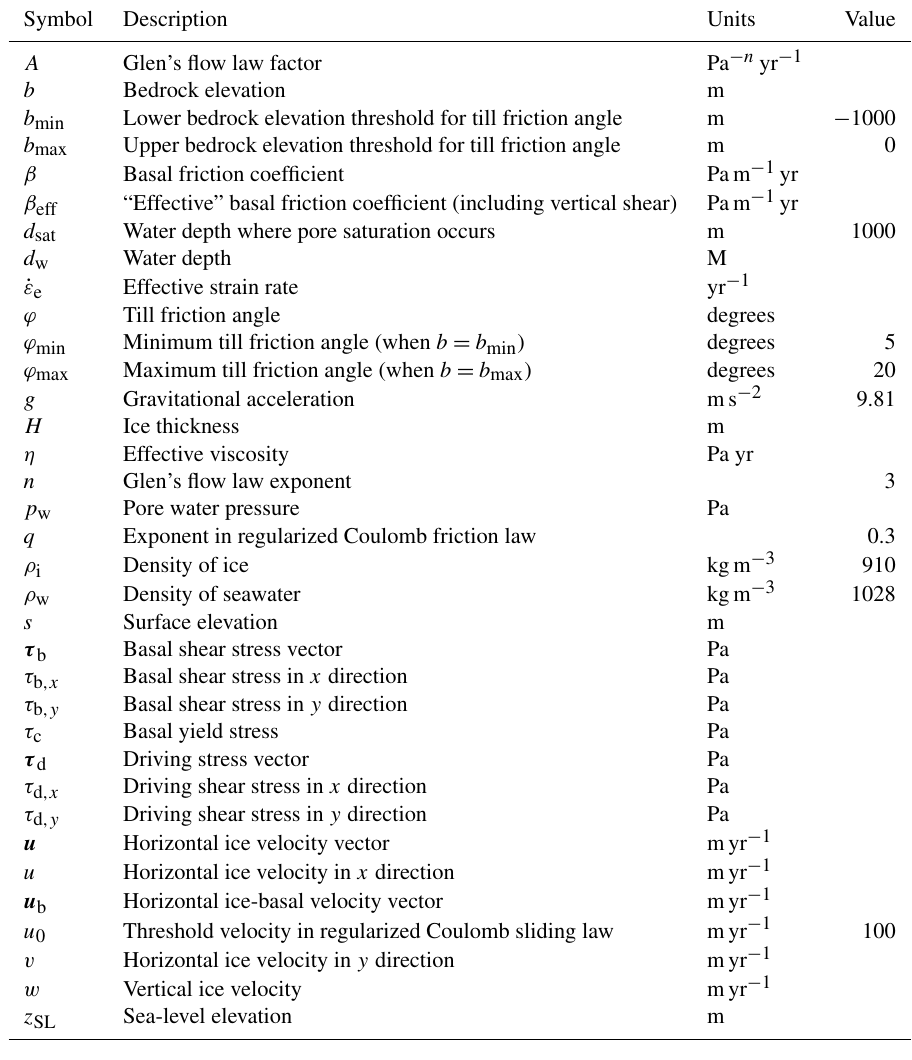
Table 2. Model symbols, units, and default values where applicable. Symbol